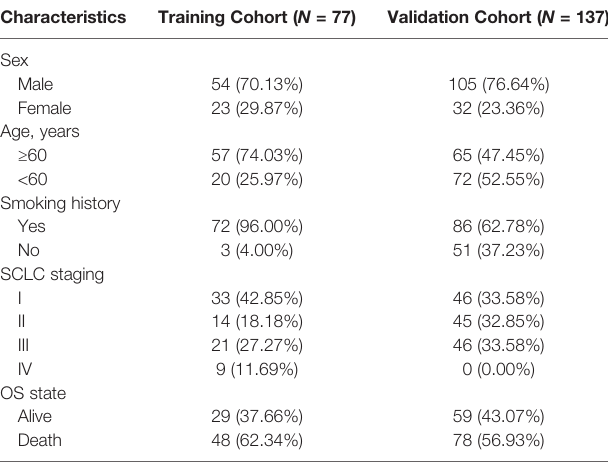
TABLE 1 | Clinicopathological characteristics of enrolled